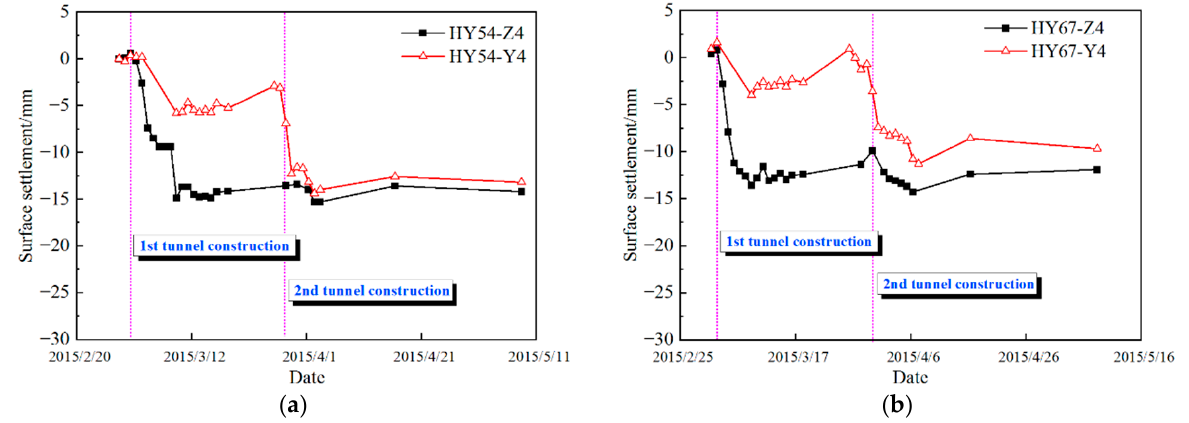
Figure 5. Settlement duration curves of monitoring sections. ( a ) Monitoring section HY-54. ( b ) Monitoring section HY-67.